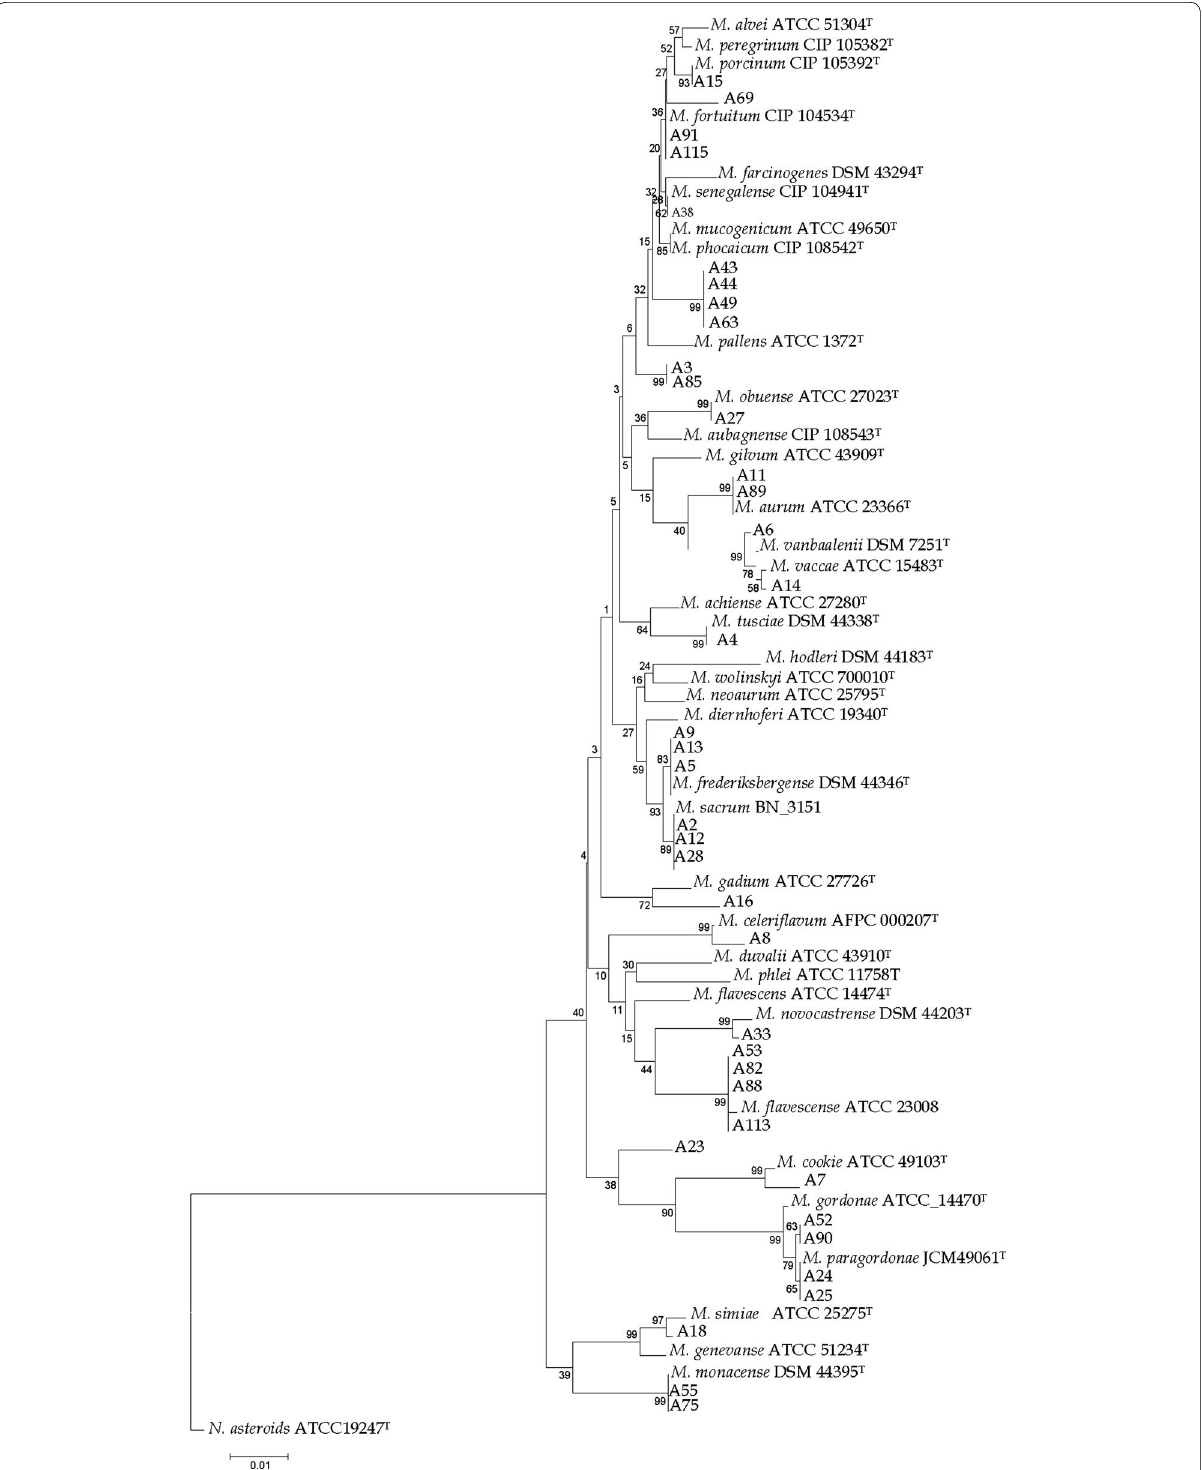
Fig. 2 16S rRNA sequence based phylogenetic tree for Iranian biodegrading NTM isolates and the nearest validated species of mycobacteria by using the neighbor-joining method. The figures at each node represent bootstrapping values. The tree was rooted with N.